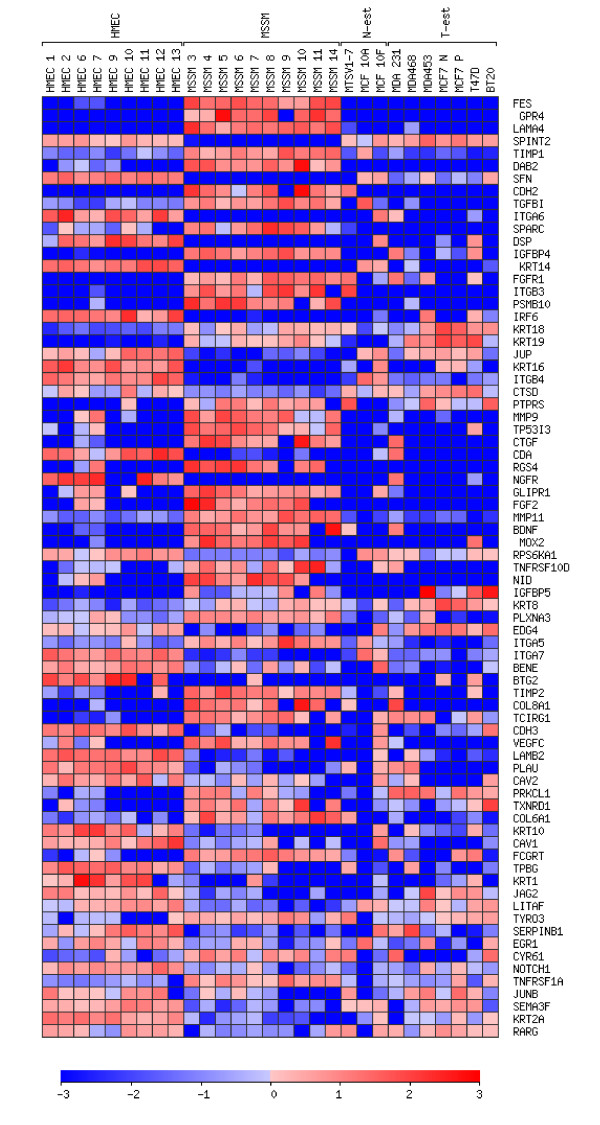
Relative expression of all the 29 cell linestested by Atlas arrays. Output of the Pomelo tool showing the log2 of the relative expression of the selected genes in each cell line to the average expression of all the cell lines. The 75 genes shown here were considered differentially expressed by SAM and by AtlasImage, with at least a 2-fold change for both programs, when we compared the HMEC and MSSM cell classes.